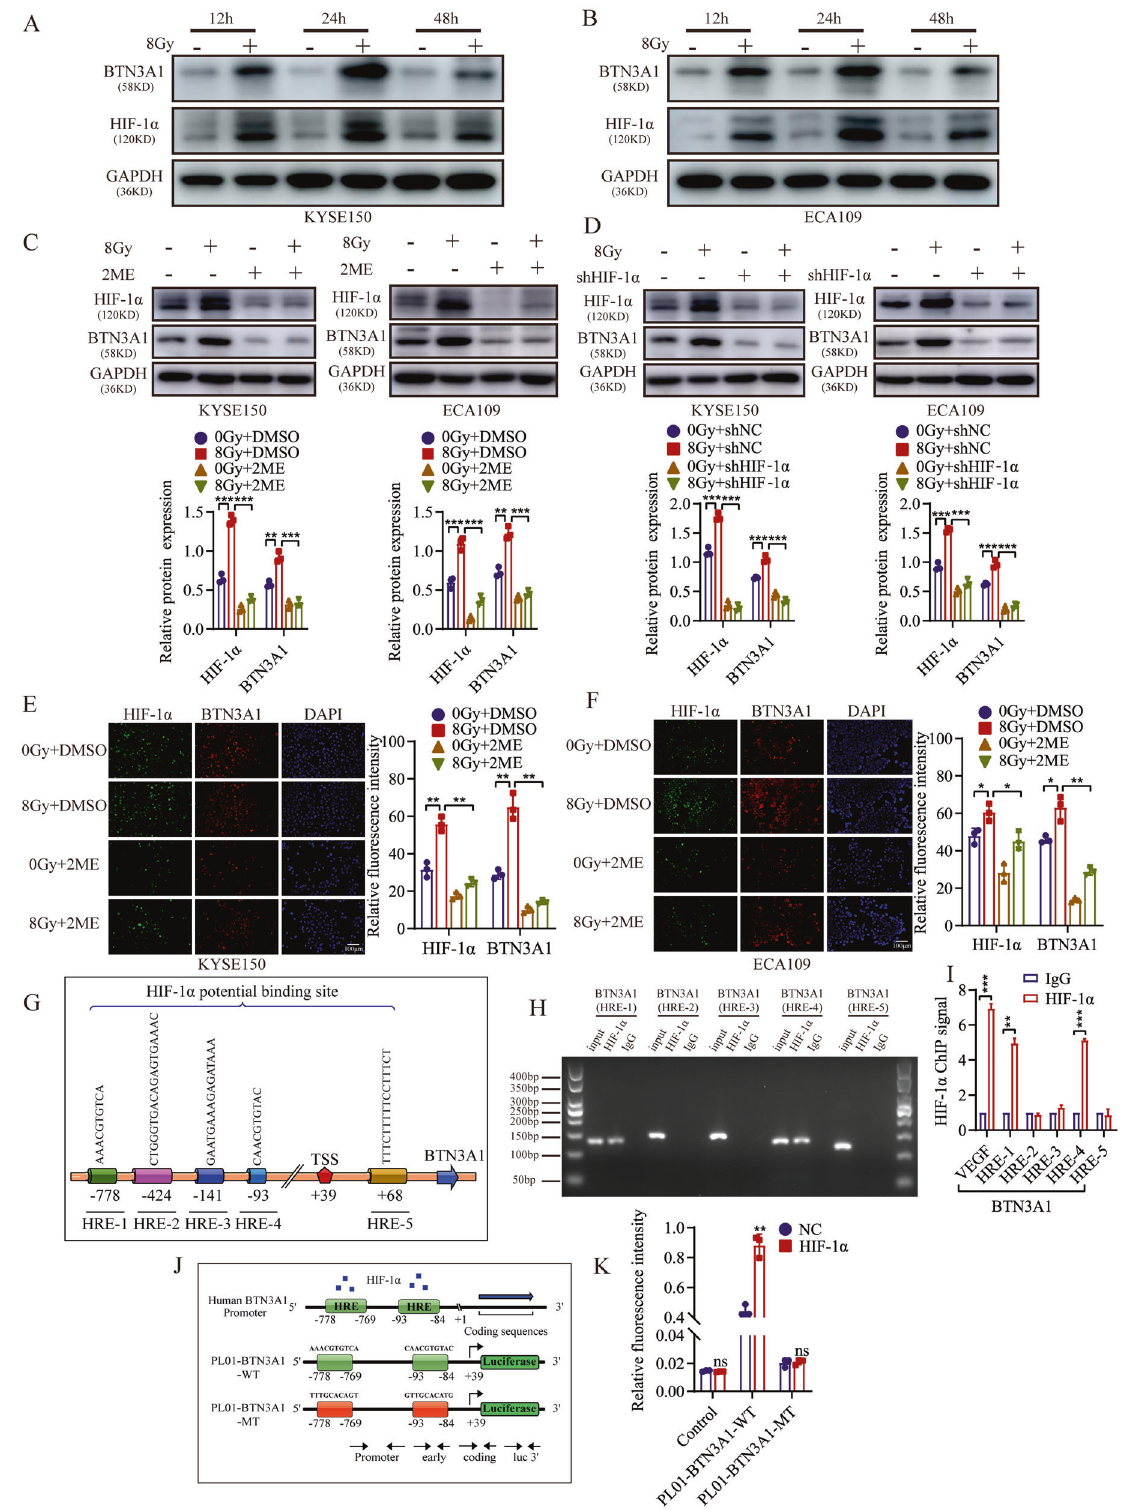
and clinicopathologic characteristics was determined using the Chi-square test. OS and RFS were evaluated by the Kaplan – Meier method and compared with the log-rank test. The predictive value of BTN3A1 expression in the specimen was determined by analyzing the ROC curve analysis and estimating the AUC. A univariable Cox analysis was performed to determine the prognostic signi fi cance of the parameters. Multivariate